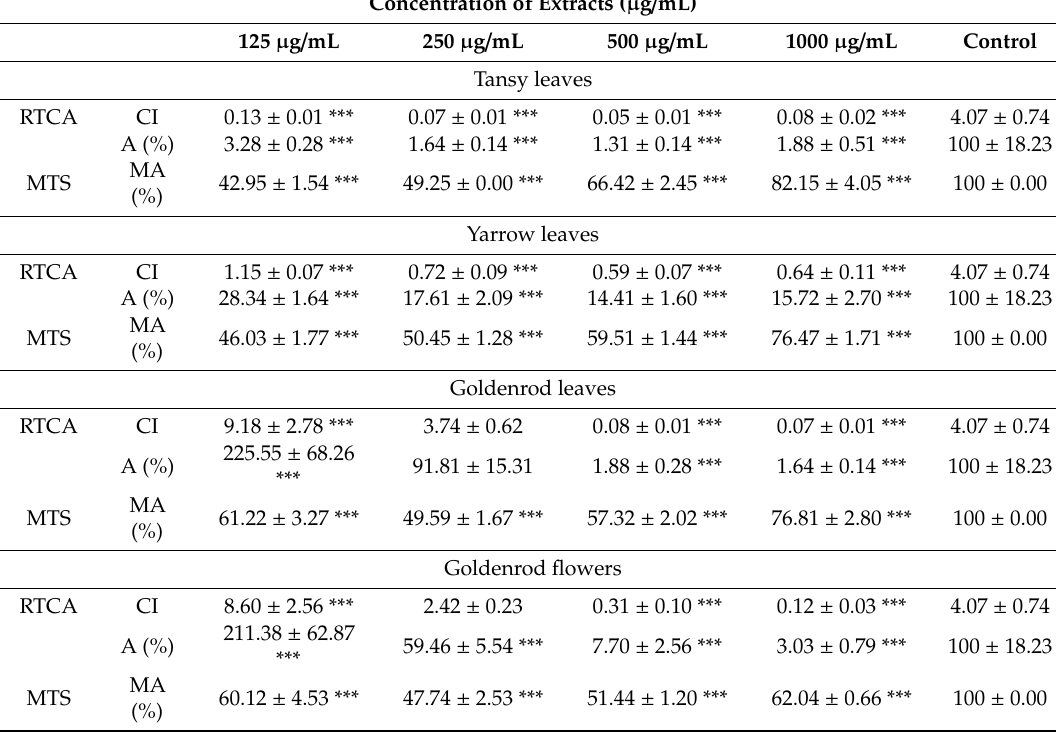
Table 1. The e ff ect of the extracts on adherence and metabolic activity of IPEC-1 cells after 48 h of